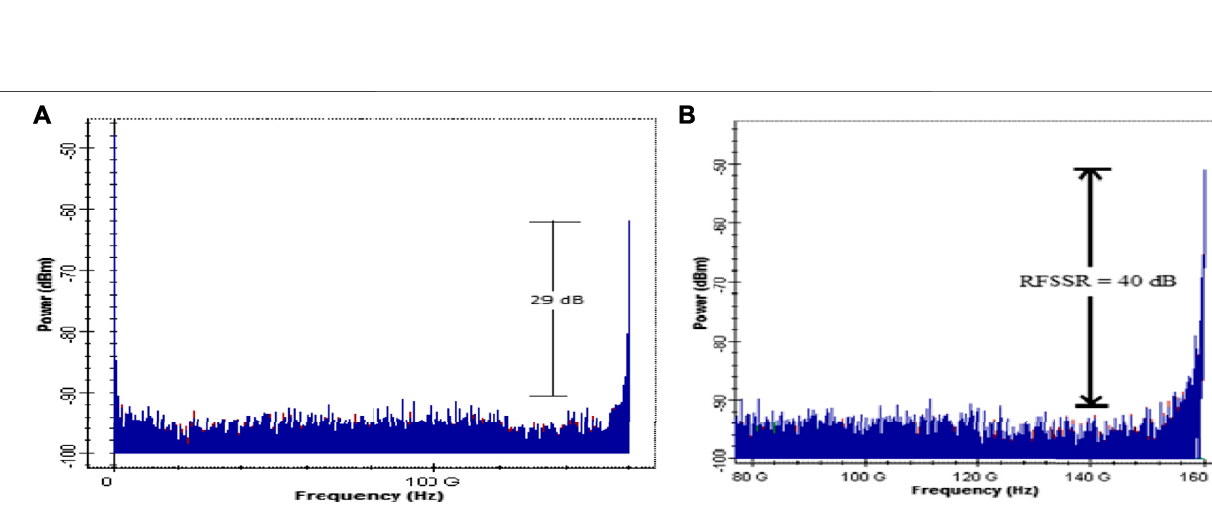
Frontiers in Physics |